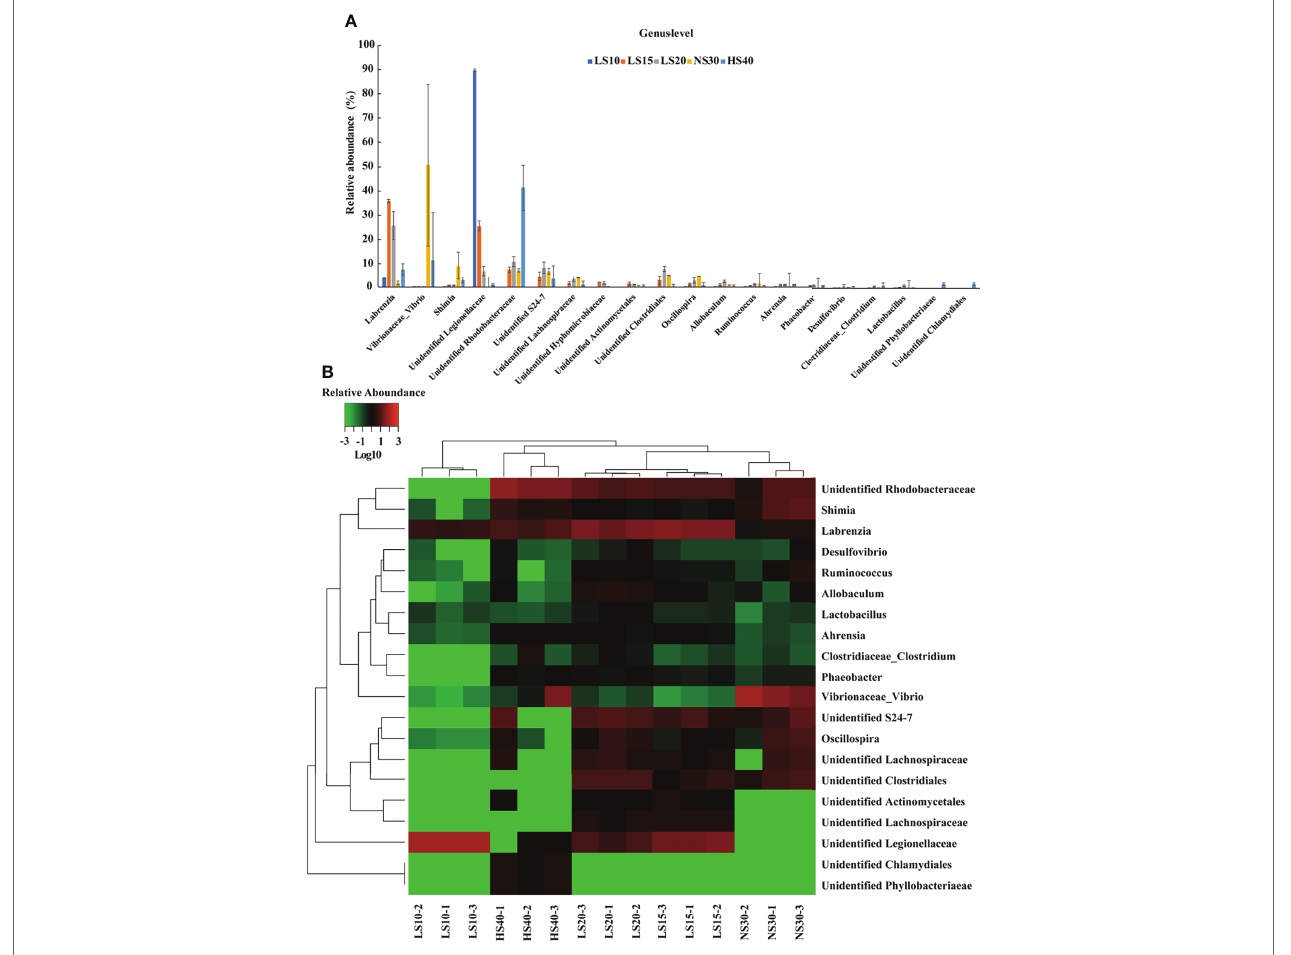
FIGURE 5 | Changes of U. unicinctus intestine microbial species at the genus level in different salinity groups. (A) Relative abundance of the intestine microbiota at the genus level in 10‰ (LS10), 15‰ (LS15), 20‰ (LS20), 30‰ (NS30), and 40‰ (HS40) salinity groups. The data are mean values of three replicates ± SD (n = 3). (B) Heat map indicating the abundance of each bacterium at the genus level. Red represents a higher abundance. Green indicates a lower